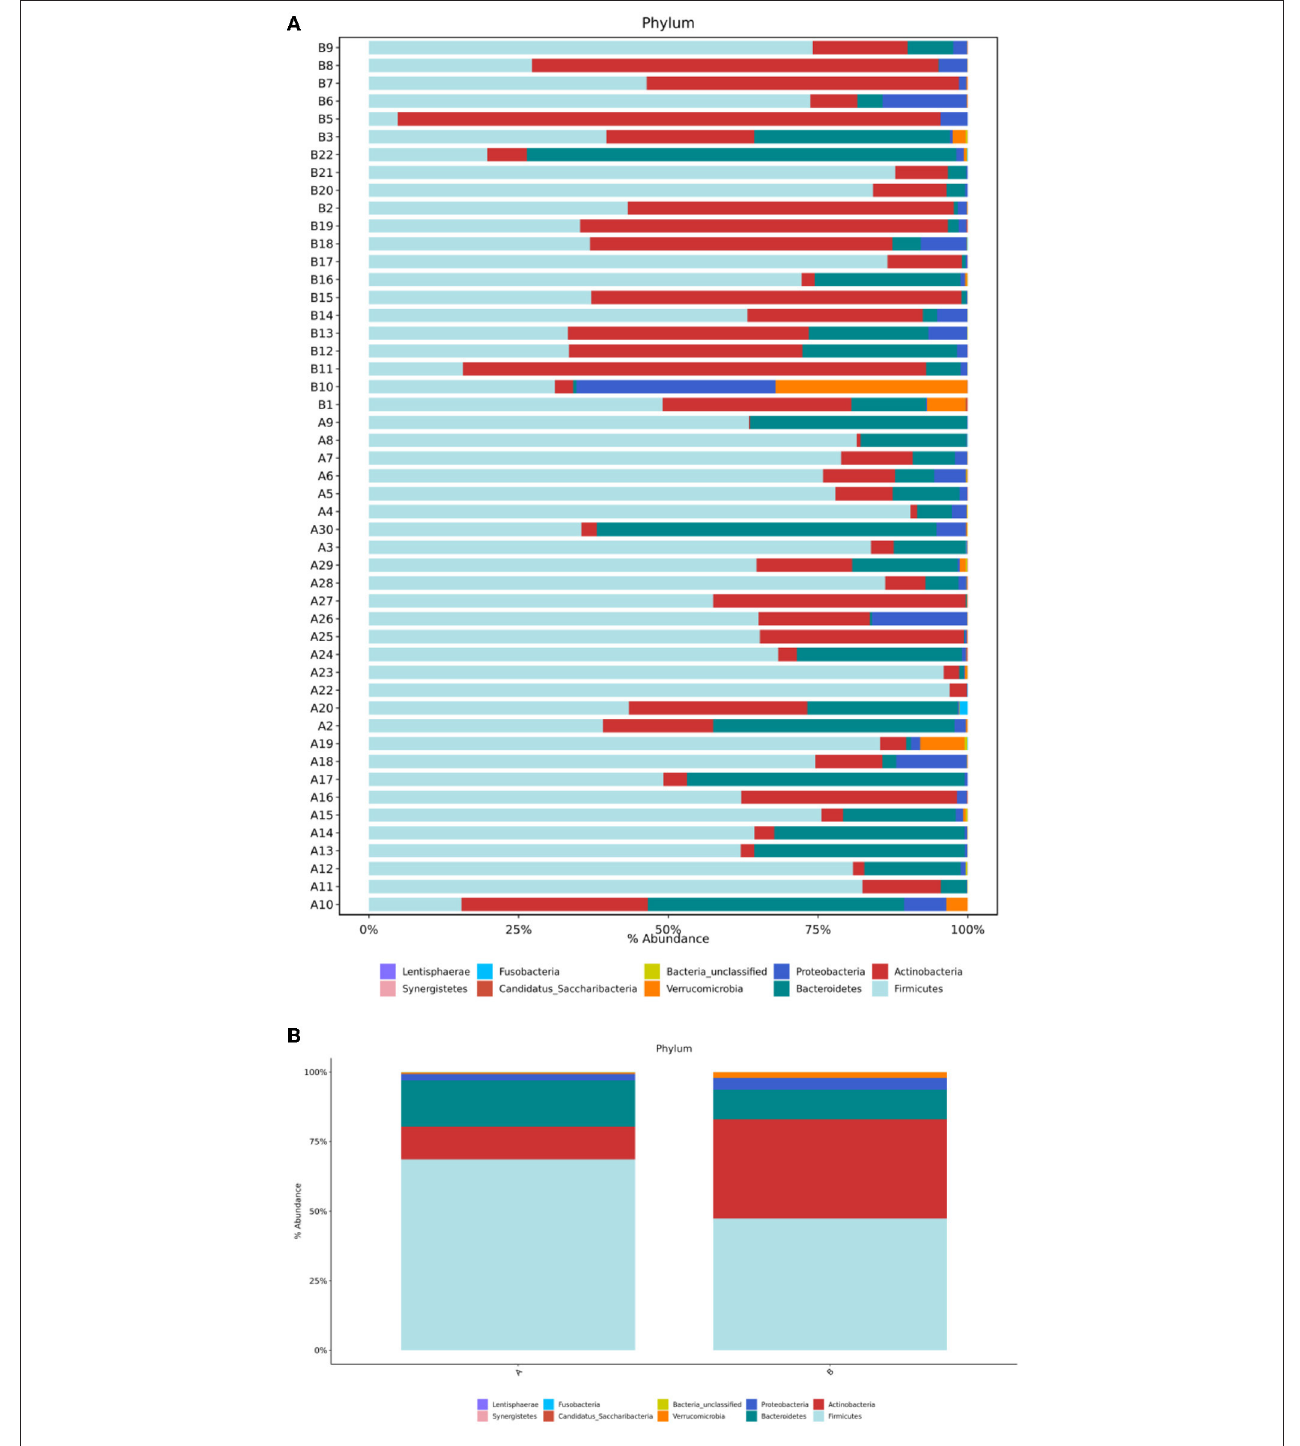
FIGURE 3 | (A) Structural composition analysis of the gut microbiota in each sample at the phylum level. (B) Comparison of relative abundance and composition of bacteria in the two groups at the phylum level. Group A, TD group; Group B, control group.